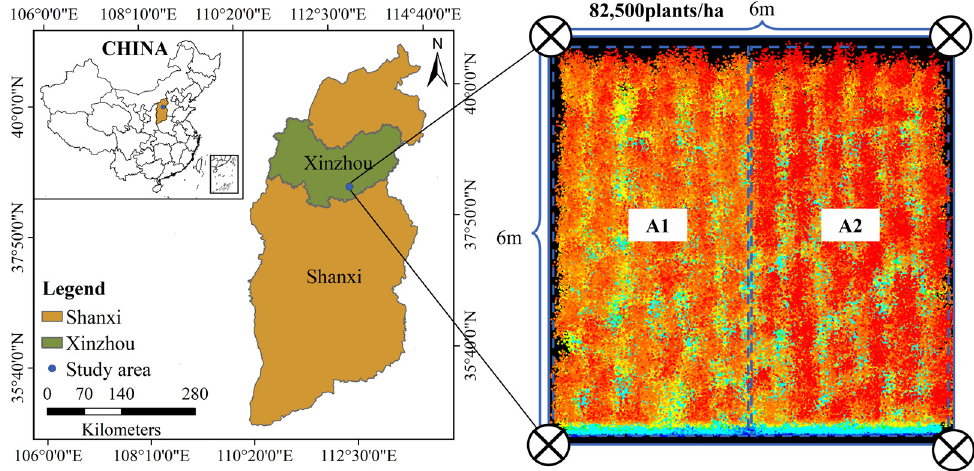
Figure 1. Geographical position of study area.